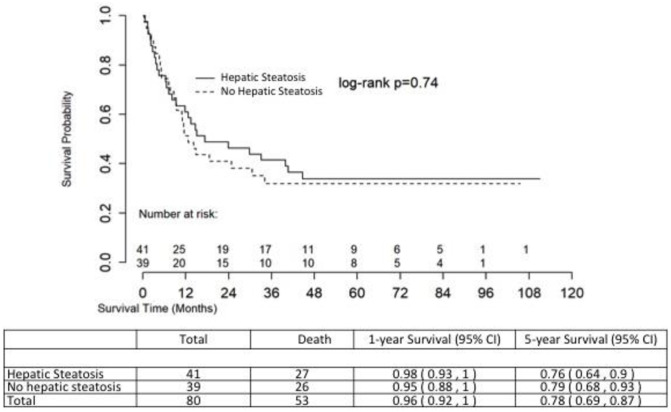
Unadjusted overall survival.